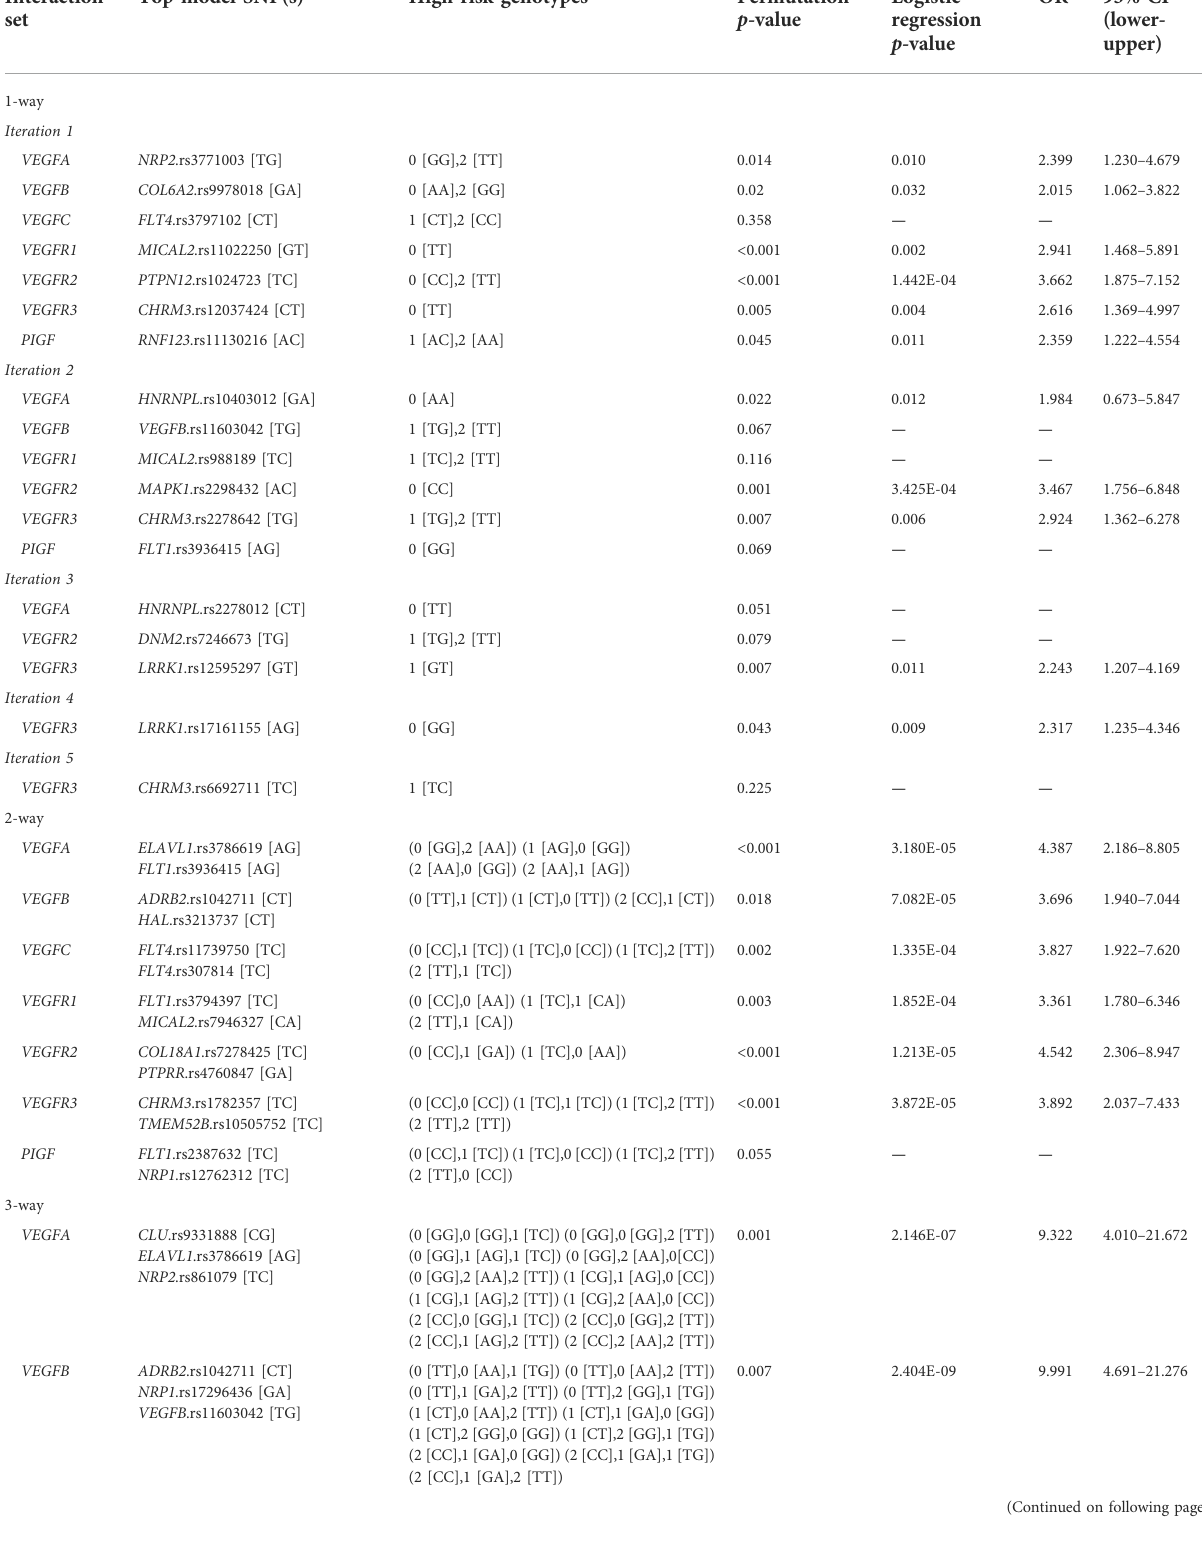
TABLE 4 Multivariable logistic regression analysisresults for the top GMDR 0.9 models in the VEGF interaction network setanalyses(disease-speci fi c